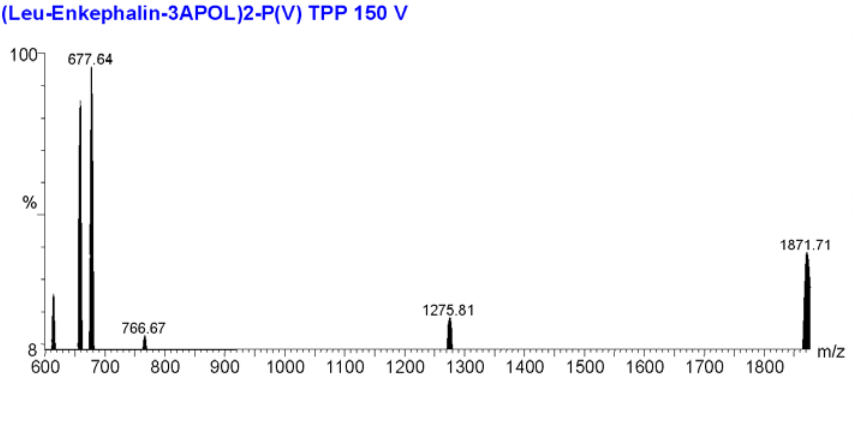
Fig. 4 ES-MS spectra of (Leu-enkephalin-3APOL)2P(V)TPP recorded at 150 V. The compound follows the fragmentation pattern characteristic of P(V) porphyrins. Loss of one axial substituent (m/z = 1275), loss of the other axial moiety, which yields the dihydroxy-P(V)-TPP (m/z = 677) that eliminates a water molecule, giving O=P(V)-TPP (m/z = 659). All of the species can fragment to yield free TPP (m/z =